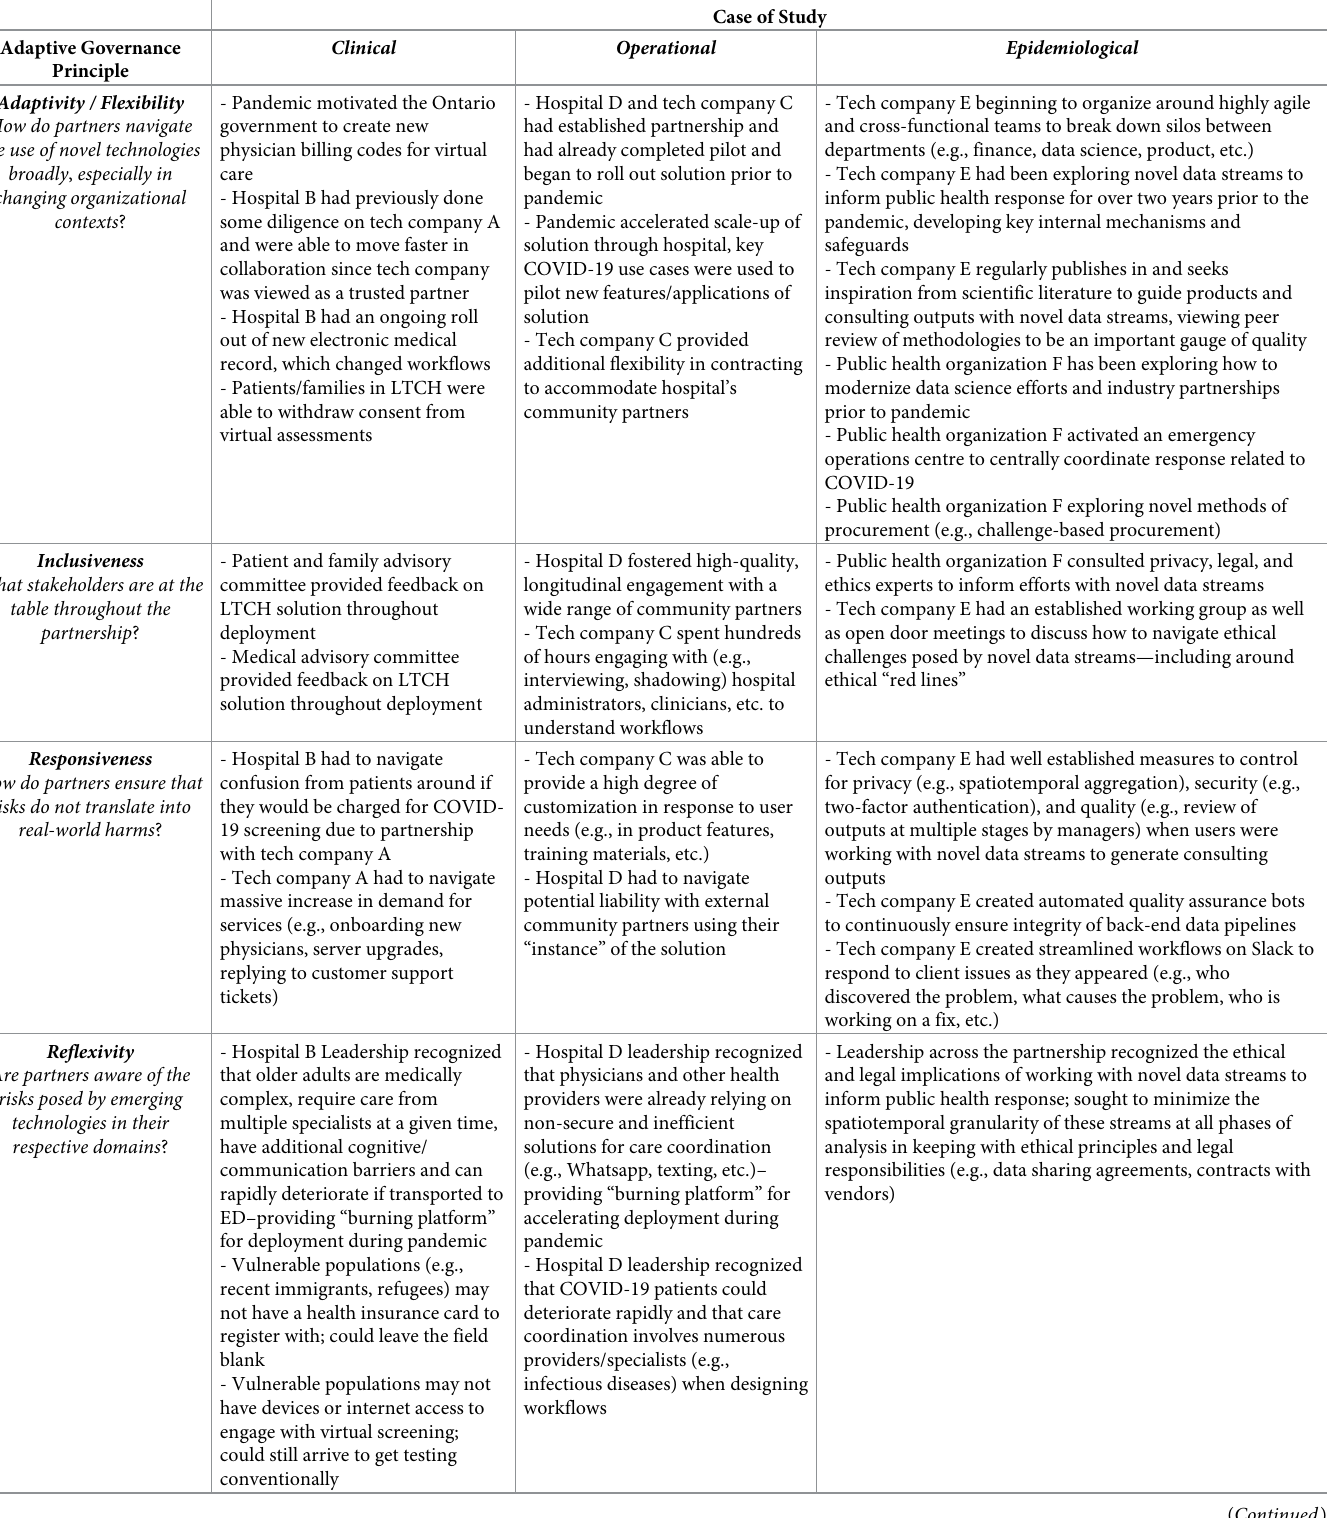
Table 1. Mapping the six higher-order principles of adaptive governance by systemic oversight (Blasimme and Vayena, JMLE 2018) to key events or concepts in the three cases of